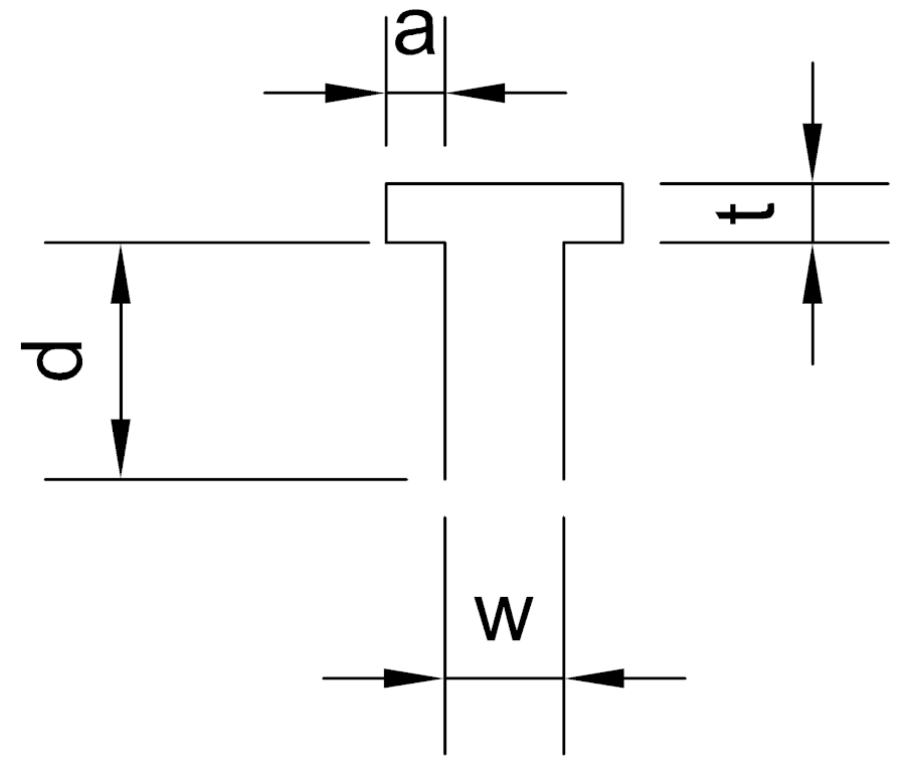
Figure 3. T-shape groove geometric